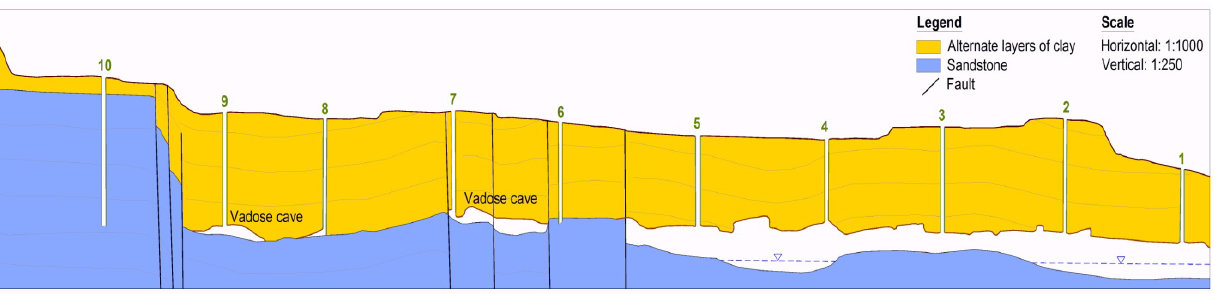
Figure 14 . Schematic cross section of the tunnel Jeni-su in Rhodes with a series of vertical wells